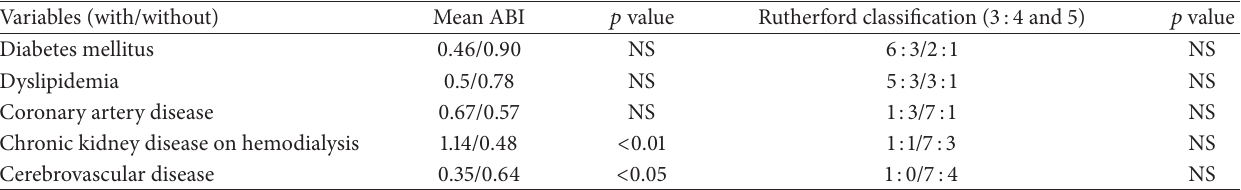
Table 2: The comparisons between comorbidities and peripheral arterial